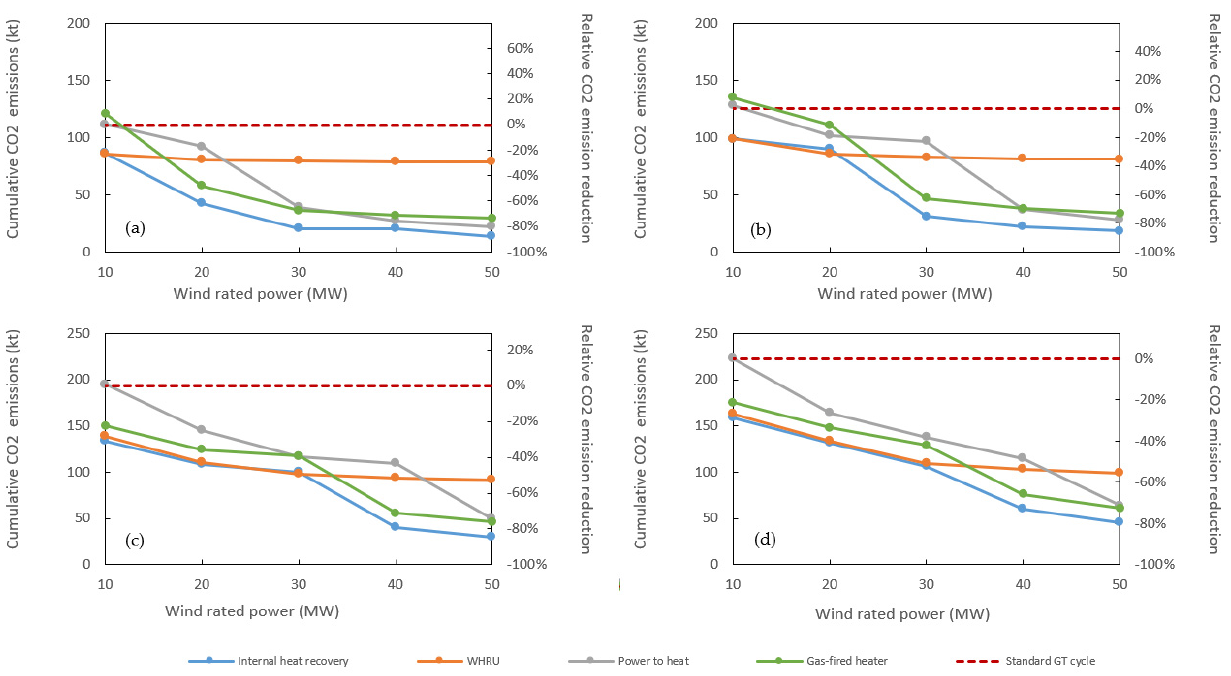
Figure 5. Absolute and relative CO 2 emissions for the different configurations analysed and for different H/P ratios: ( a ) H/P = 0.40, ( b ) H/P = 0.32, ( c ) H/P = 0.23, ( d ) H/P = 0.20.